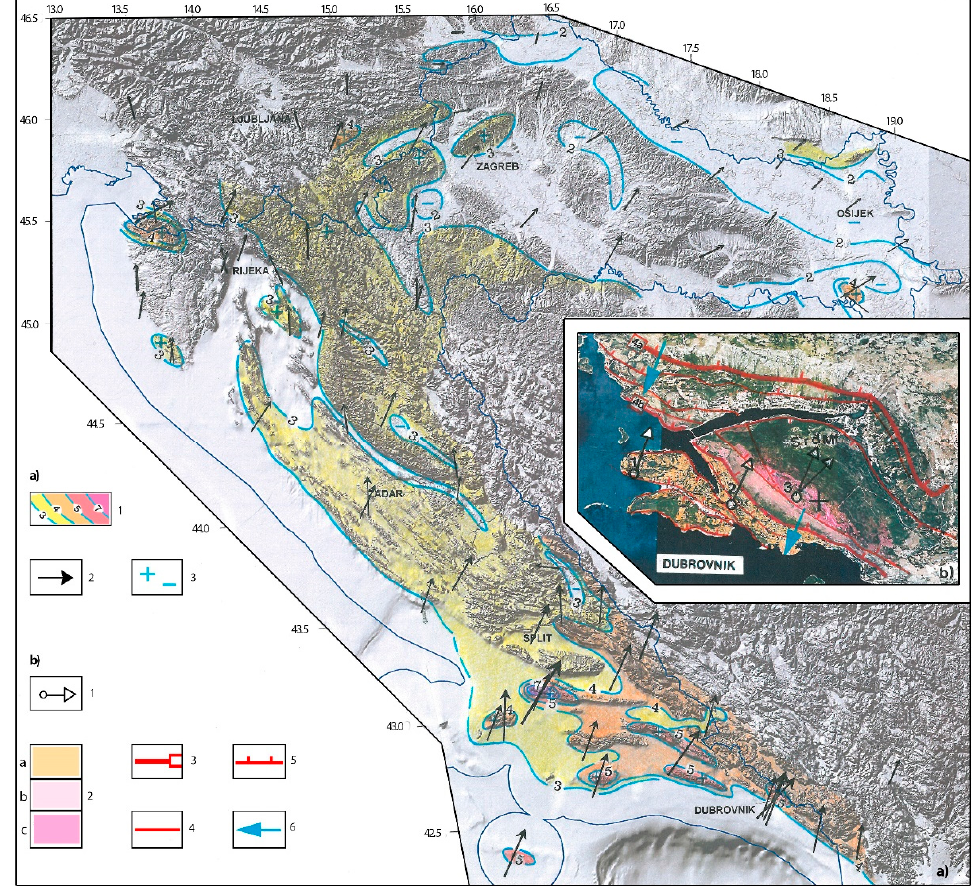
Figure 4. ( a ) Amplitudes and directions of annual velocities at geodetic stations (2008–2013). Legend ( a ): 1—velocity am- plitudes; 2—movement directions at geodetic stations; 3—maximum and minimum movement amplitudes. ( b ) Ampli- ( a ): 1—velocity amplitudes; 2—movement directions at geodetic stations; 3—maximum and mini- tudes and directions of annual velocities around Dubrovnik. Legend ( b ): 1—direction of annual velocities at geodetic mum movement amplitudes. ( b ) Amplitudes and directions of annual velocities around Dubrovnik. points in mm/yr; 2—amplitudes greater than 4 (a), 5 (b), and 7 (c) mm/yr at geodetic stations in Dubrovnik DUBM(1), Legend ( b ): 1—direction of annual velocities at geodetic points in mm/yr; 2—amplitudes DUBR(2), DUBI, and DUB2 (3); 3—major fault at Mosor–Biokovo–Dubrovnik (4a), bordering regional structural units and its main branch (4b); 4—faults extending along local reverse structures and branches of major faults; 5—reverse faults; 6— the movement directions of structural parts along the faults, according to geological measurements.